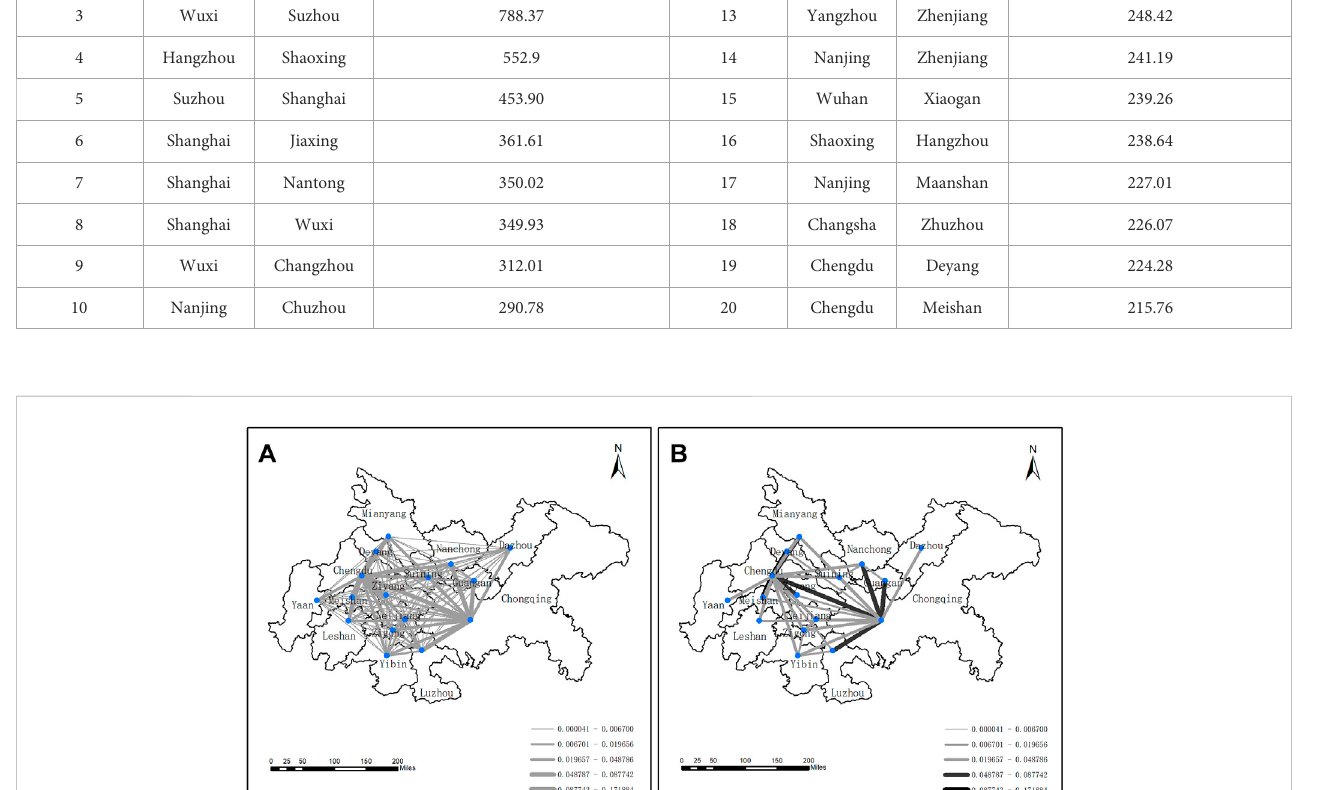
urban linkages with economic linkage strength less than or equal to 0.01. The connection values were divided into fi ve ranges, represented by line color and thickness.